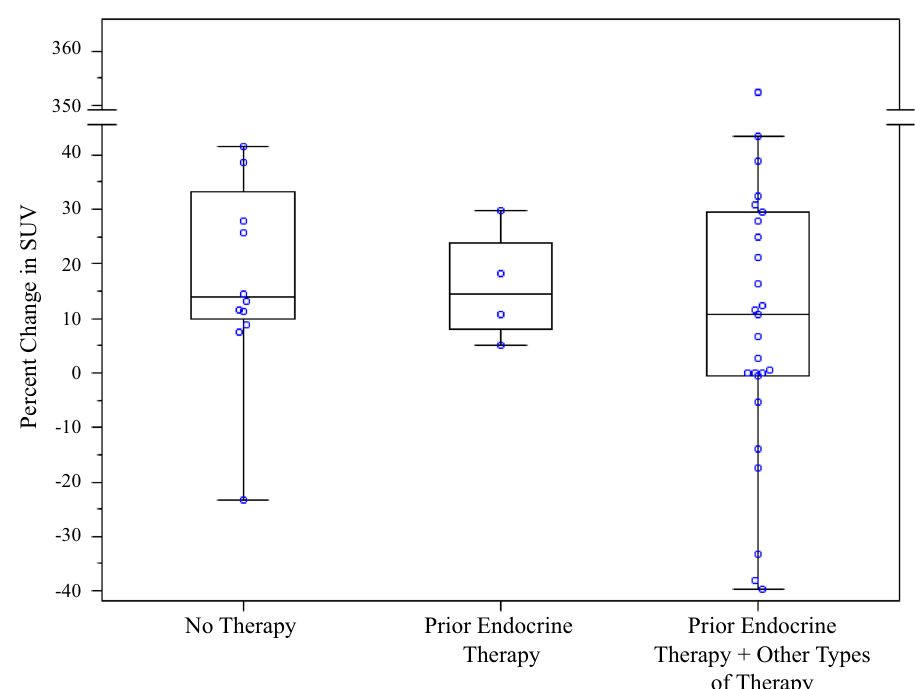
Fig. 4 Percent change in tumor FFNP uptake with estradiol challenge based on prior therapies. Relationship of percent change in standardized uptake value (SUV) for FFNP after estradiol challenge to previous subject therapy. Table 4 . Relationship of serum estrogen level and response (a) and change in FFNP uptake after estradiol challenge